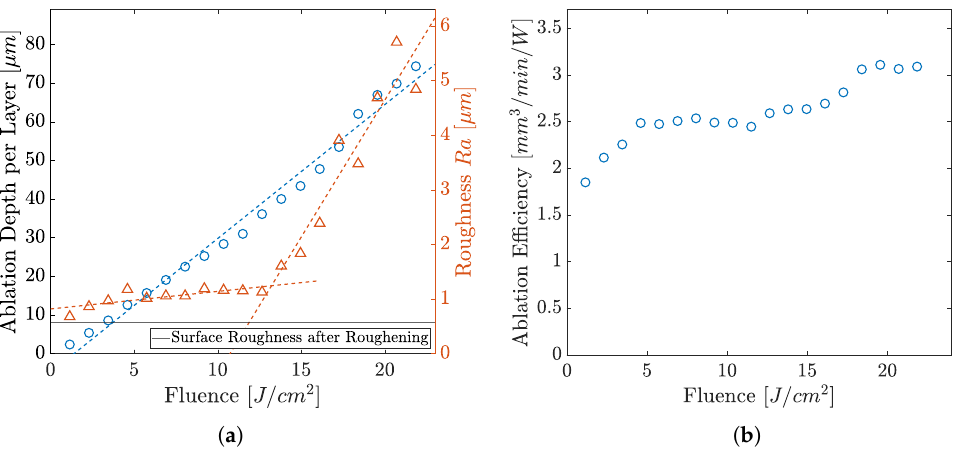
Figure 6. Ablation values of COC by the UV laser: ( a ) ablation per pass and roughness; ( b ) ablation efficiency.